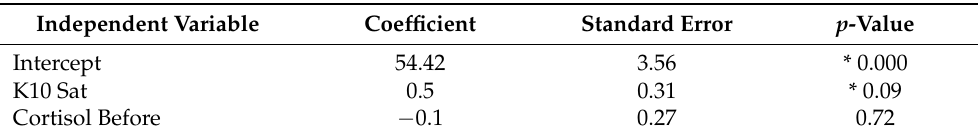
Table 7. Regression results of MASQ Saturday scores (dependent variable), K10 Saturday scores, and saliva cortisol levels before exercise (independent variables) . * p < 0.1.